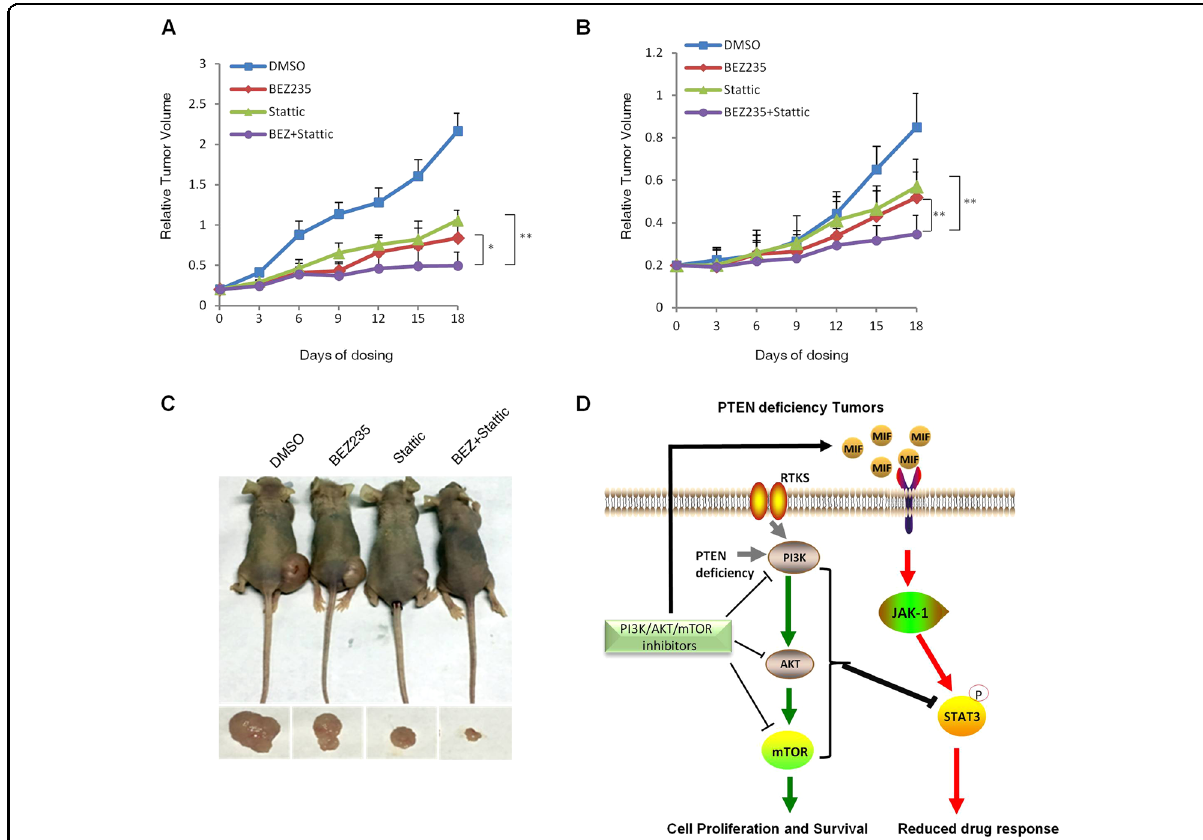
Fig. 6 Combined inhibition of PI3K/mTOR and STAT3 activity signi fi cantly inhibits the growth of tumor xenografts. Growth curve of A HGC- 27 and B MDA-MB-436 xenografts in mice treated with BEZ235 (30 mg/kg) and/or Stattic (3.75 mg/kg) for 20 days. The relative tumor volumes measured every 3 days are plotted. Error bars represent means ± SD ( n = 6 mice per group). * P < 0.05. C Representative images of living nude mice injected with HGC-27 cells treated with BEZ235, or Stattic, or BEZ and Stattic or DMSO as indicated (upper panel). Stripped tumors are shown (lower panel). D Schematic representation of feedback activation of STAT3 limits the response to PI3K/AKT/mTOR inhibitors in PTEN-de fi cient cancer cells. Inhibition of the PI3K/AKT/mTOR signaling pathway led to the feedback activation of STAT3, which attenuated the anti-proliferative effects of PI3K/ AKT/mTOR inhibitors in the PTEN-de fi cient cancer cells. PI3K/mTOR inhibitors increased the expression and secretion of macrophage migration inhibitory factor (MIF) and activated the JAK1/STAT3 signaling pathway. Both cancer cells and in vivo tumor xenografts showed that the combined inhibition of PI3K/AKT/mTOR and STAT3 activity enhanced the inhibitory effect of BEZ235 on the proliferation of PTEN-de fi cient cancer cells. The reactivated STAT3 limits the repression of PI3K/AKT/mTOR inhibitors on PTEN-de fi cient tumor